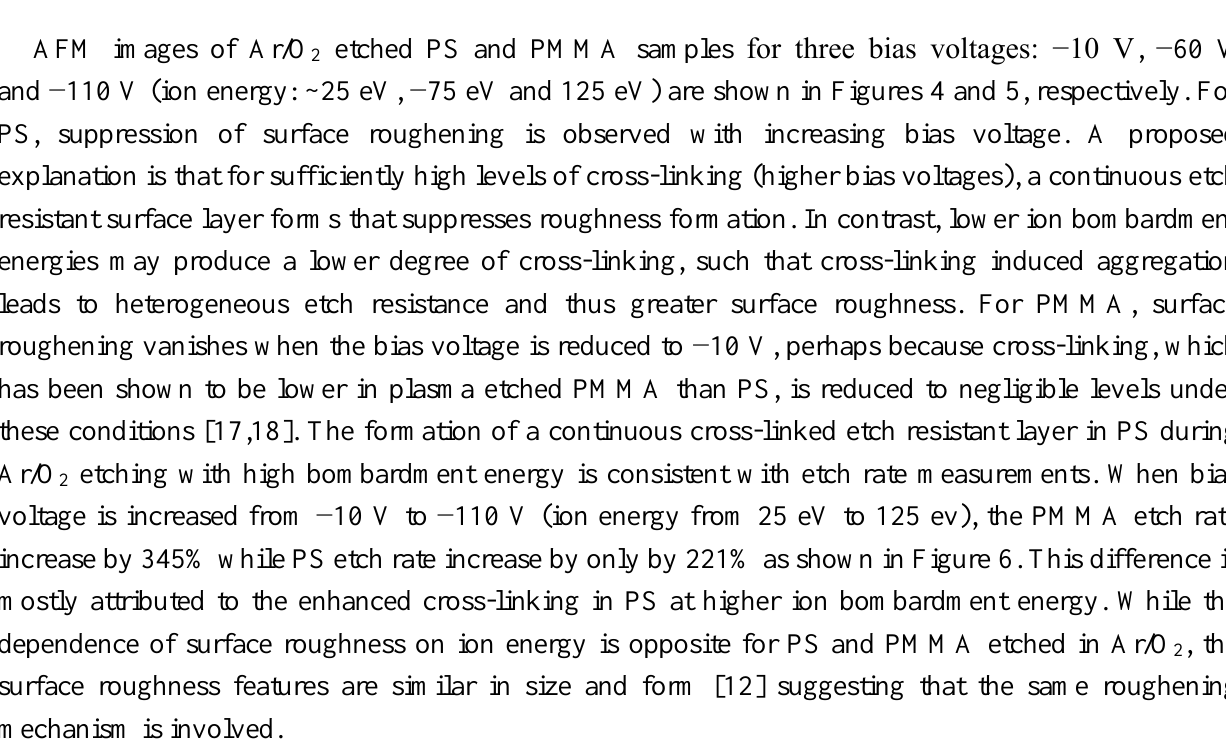
etched PS film with bias voltages of ( a ) −10 V, ( b ) −60 V 2